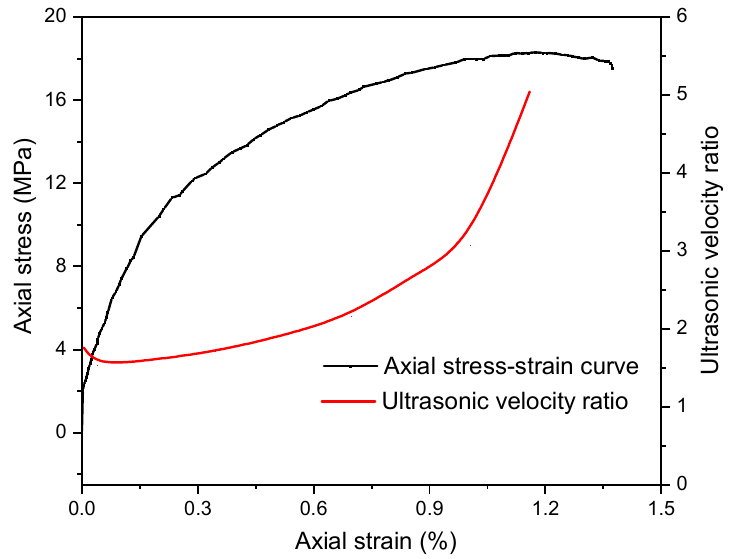
Figure 8. Relationship between axial stress-strain curve and ultrasonic velocity ratio at different deformation stages for sample SA-2 under uniaxial compression.